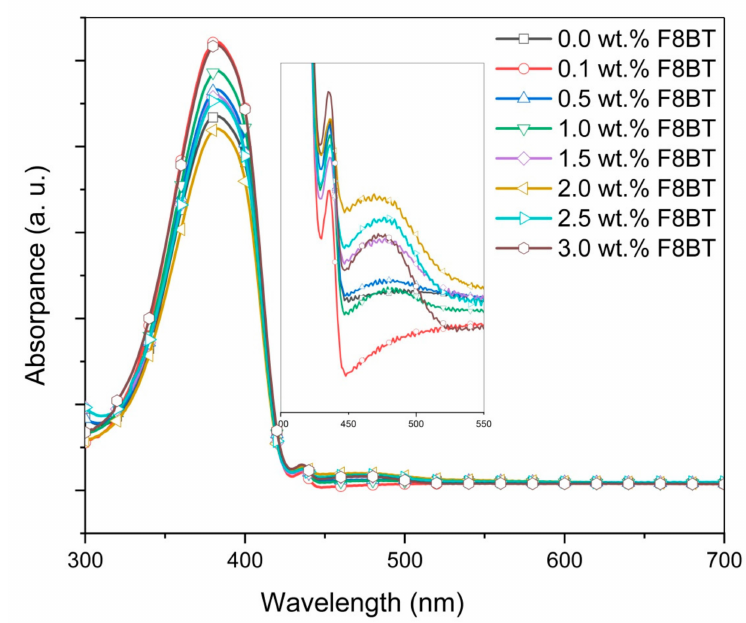
Figure 3. Absorbance spectra of poly(9,9-dioctylfluorene-2,7-diyl) (PFO) / poly 9,9-dioctylfluorene-alt -benzothiadiazole (F8BT) / 0.3 wt.% poly(2-methoxy-5(2-ethylhexyl)-1,4 -phenylenevinylene (MEH-PPV) films with di ff erent wt.% of